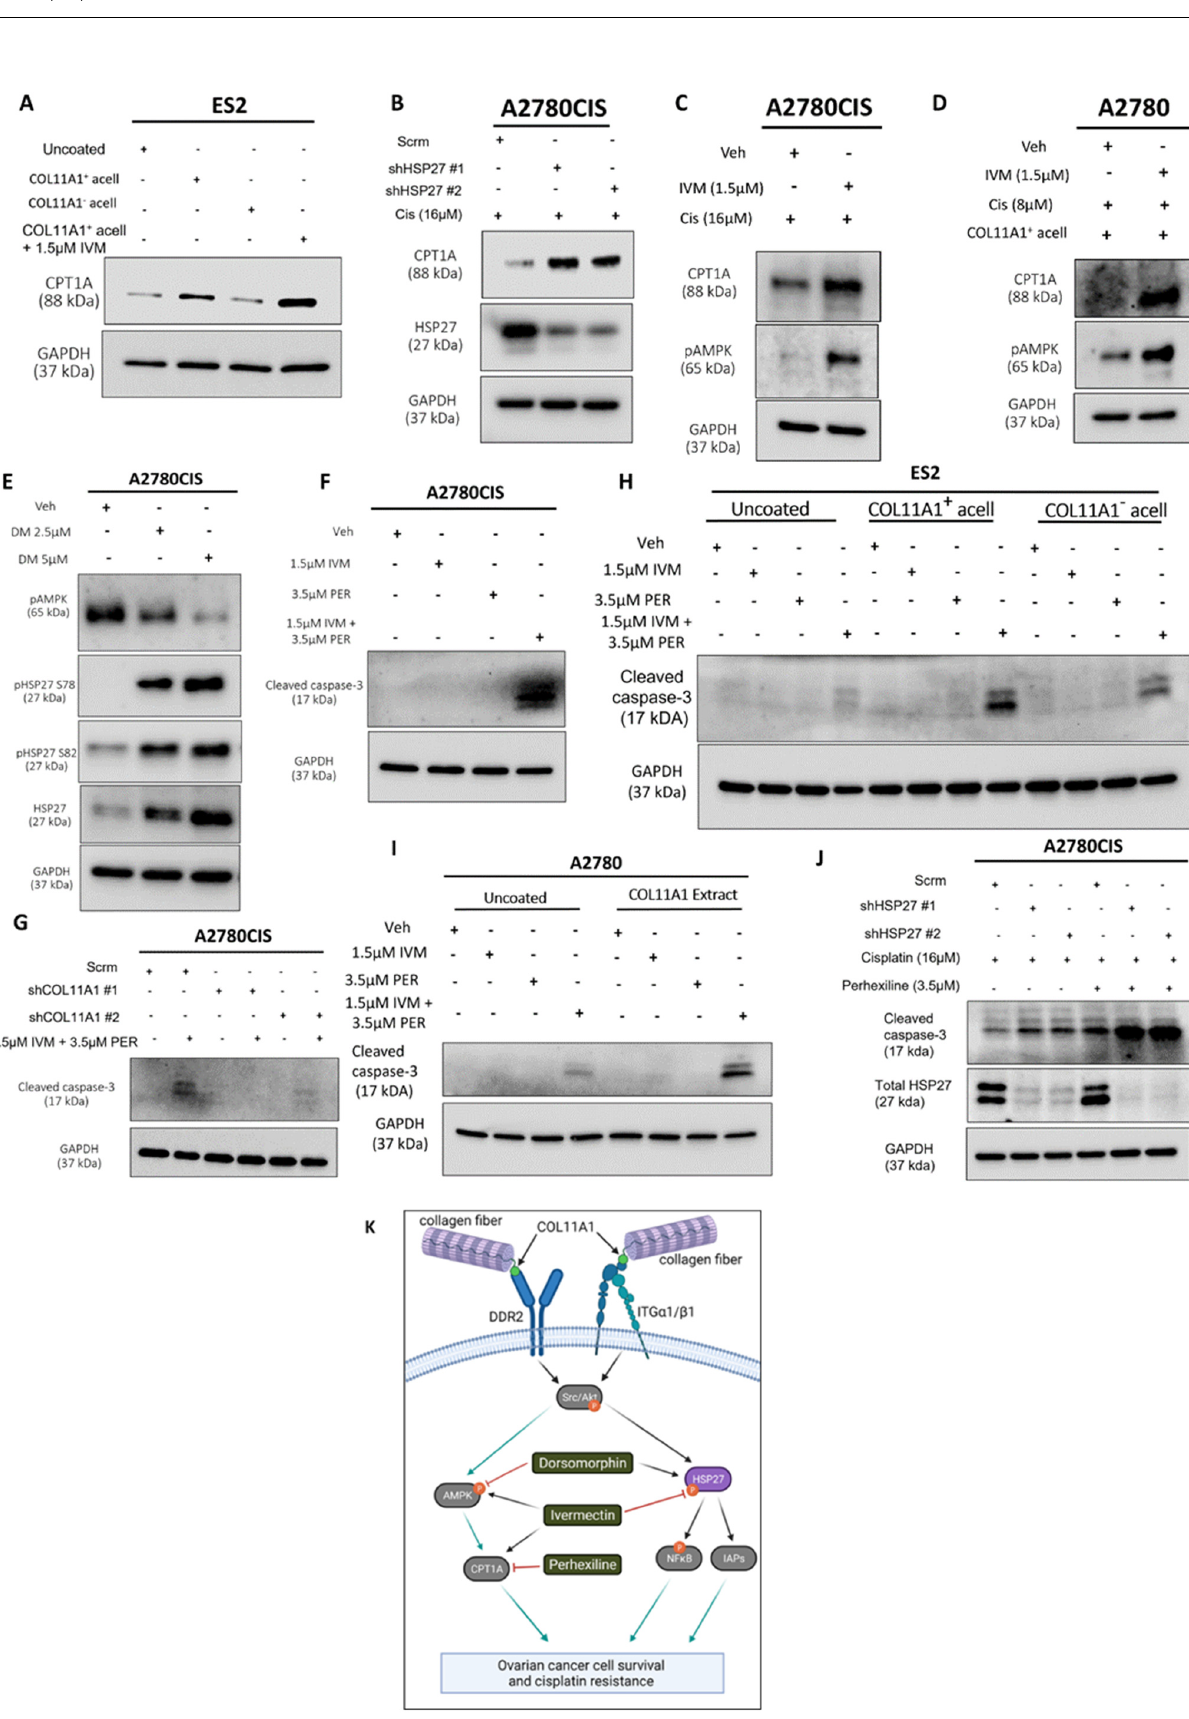
Figure 6. HSP27 synergizes with FAO to enhance cisplatin resistance. ( A ) Western blot of CPT1A in ES2 cells cultured in